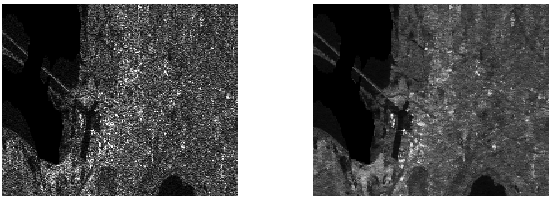
Figure 6. Temporal Classification results. (a) RDR temporal classification results, OA=0.67, (b) RKL temporal classification results, OA =0.61, (c) DSMT fusion temporal classification results, OA=0.72, (d) Temporal ground truth image.